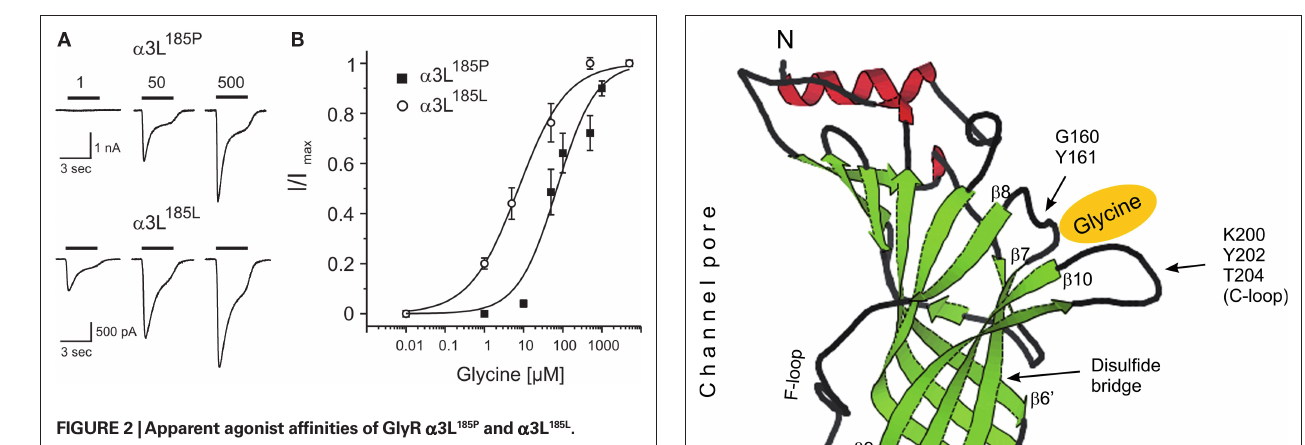
FIGURE 2 | Apparent agonist affi nities of GlyR α 3L 185P and α 3L 185L . Dose-response curves were obtained from transfected HEK293 cells. (A) Example traces of Cl − currents obtained at indicated agonist concentrations. (B) Glycine dose-response curves of HEK293 cells expressing GlyR α 3L 185P or α 3L 185L are shown. Glycine current amplitudes were normalized to maximal current amplitudes. Each data point represents the average current amplitude of 13–21 sampled cells. At − 70 mV holding potential, the apparent affi nities for glycine (EC [µM]) were 70.9 ± 16.1 50(Glycine) ( α 3L 185P ) and 7.4 ± 0.9 ( α 3L 185L ). Hill coeffi cients were 0.87 ± 0.17 ( α 3L 185P ) and FIGURE 3 | Tertiary structure of AChBP and projection of GlyR α subunit 0.70 ± 0.06 ( α 3L 185L ). Thus, the long splice variant of RNA-edited GlyR α 3L 185L associated structural determinants. Positions of the glycine (yellow) binding is a high affi nity receptor as well. Values represent mean ± SD. pocket, formed by amino acids GY and KYT (C-loop), of the disulfi de bridge between β -sheets 6’ and 7 as well as of proline residues at positions 185 ( α 1 and α 3) and 192 ( α 2) are shown. N- and C-termini and the location of the chloride channel pore are indicated. β -sheets, α -helices and coils are color- coded (green, red and black, respectively). GlyR sequence was projected on the structure view of AChBP downloaded from www.pdb.org. The position of β -sheets served as reference